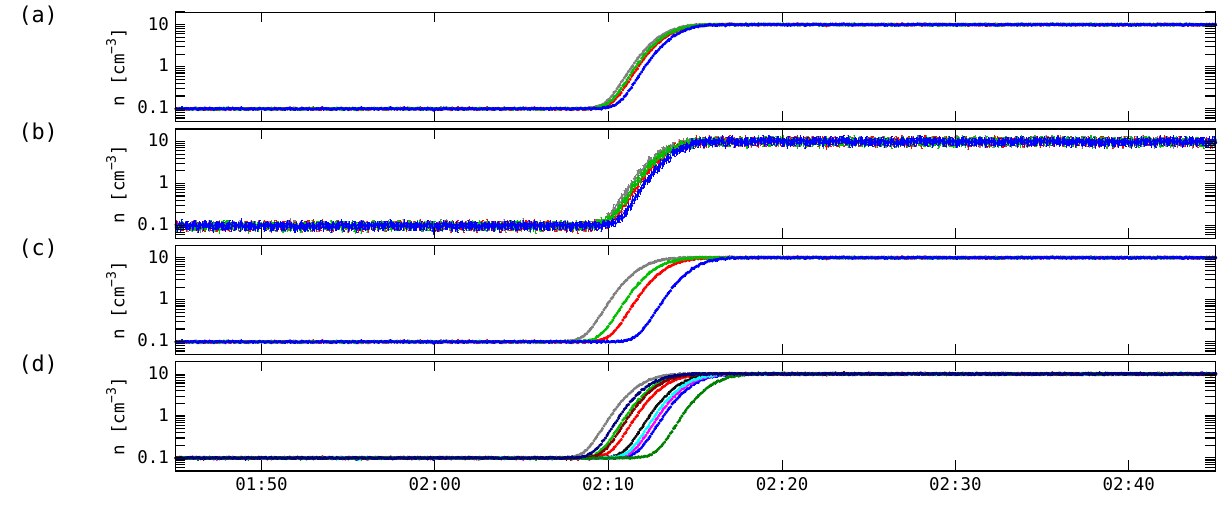
Fig. 5. Multiple spacecraft crossing a planar density interface with a half-width of 100km. The density changes by two orders of magnitude. (a) 4 spacecraft, small separation (constellation scale ∼ 150km) with relative measurement errors of 5%. (b) Idem, with 20% measurement errors. (c) 4 spacecraft, large separation ( ∼ 600km), 5% errors. (d) 10 spacecraft, large separation ( ∼ 600km), 5% measurement errors.